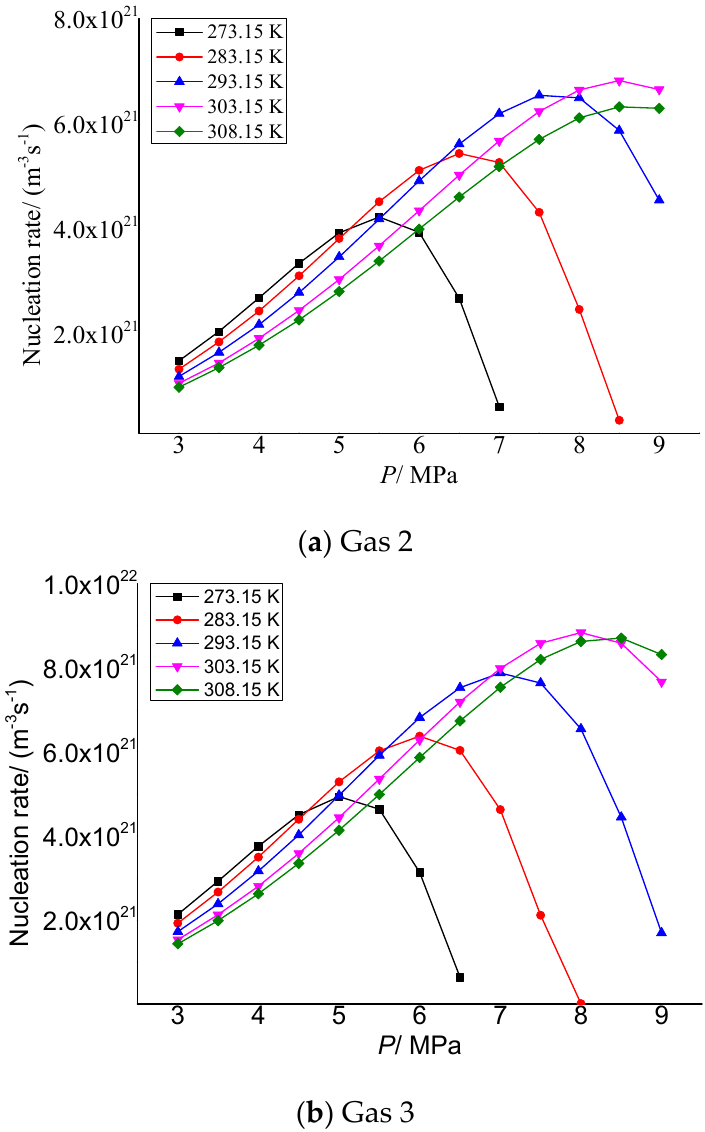
Figure 5. Curve of nucleation rate with pressure.